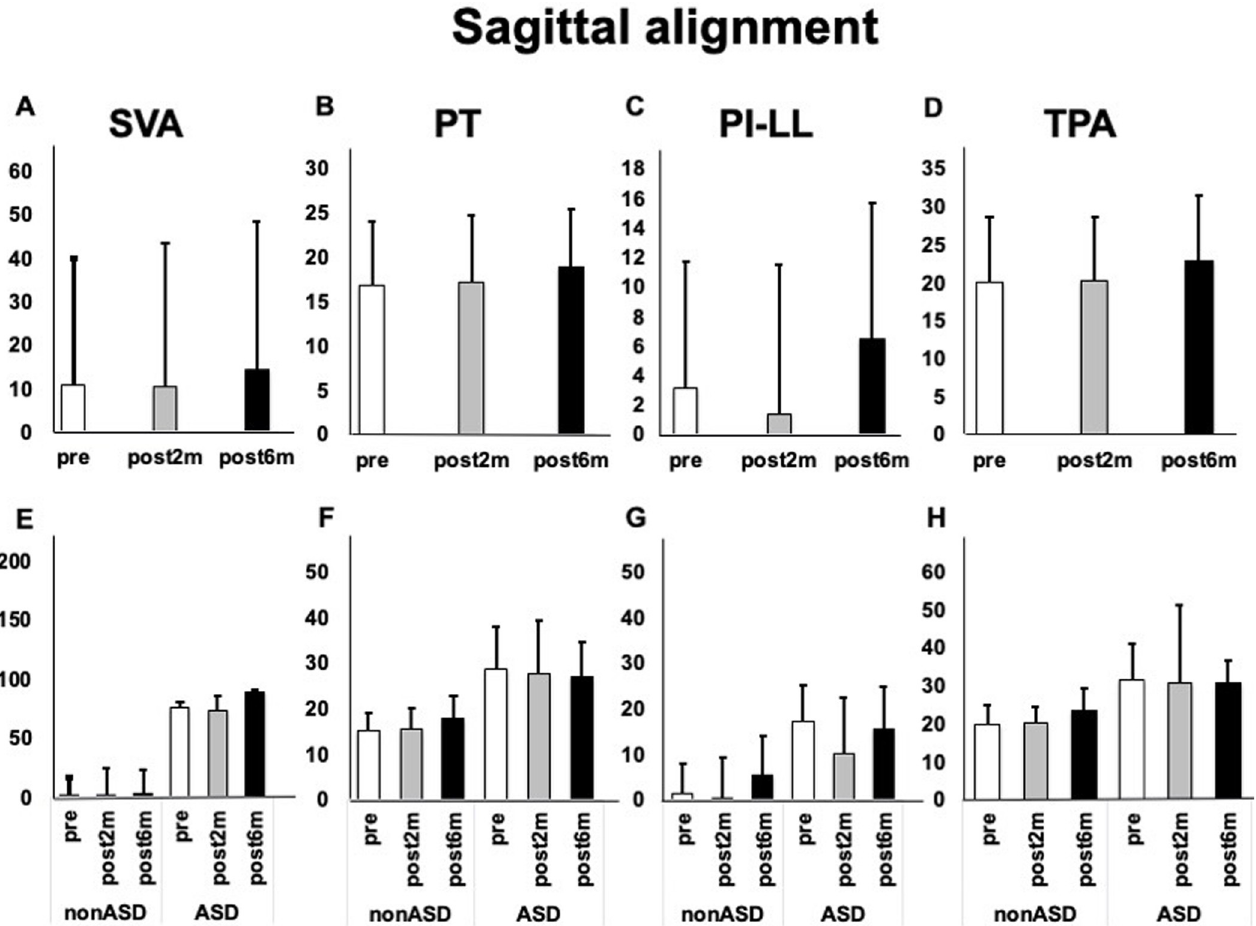
Fig 5. Sagittal alignment before and after intervention. A) Changes in the sagittal-vertical axis (SVA) in all patients. B) Changes in the pelvic tilt (PT) in all cases. C) Changes in the pelvic incidence–lumbar lordosis (PI–LL) in all patients. D) Changes in the T1 pelvic angle (TPA) in all patients. E) Changes in the SVA in the ASD and non-ASD groups. F) Changes in the PT in the ASD and non-ASD groups. G) Changes in the PI–LL in the ASD and non-ASD groups. H) Changes in the TPA in the ASD and non-ASD groups.